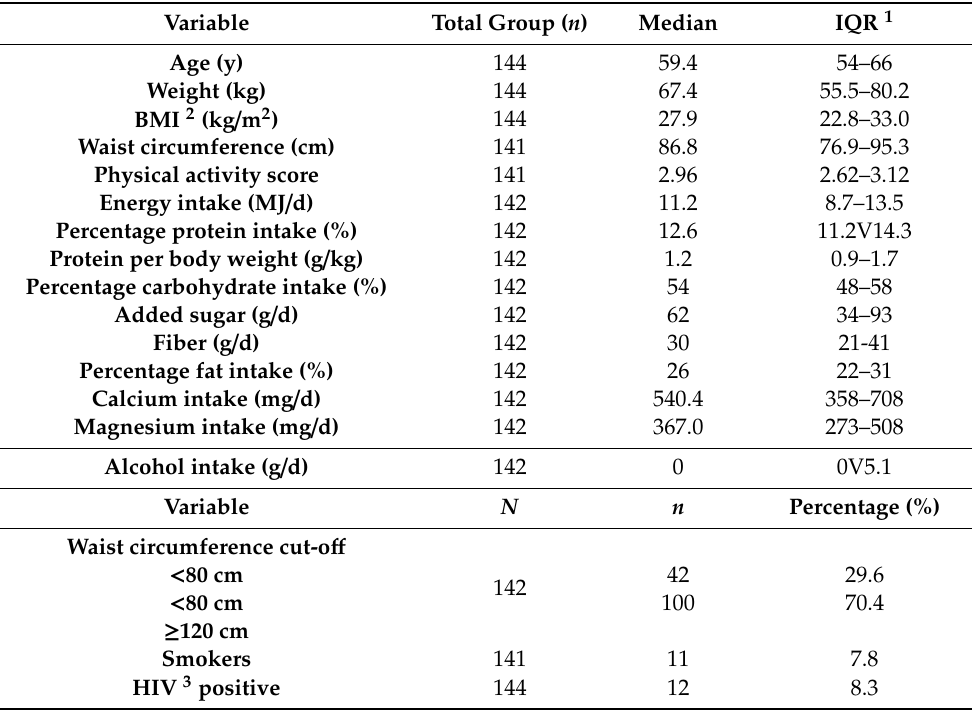
Table 2. The baseline descriptive and dietary data collected in